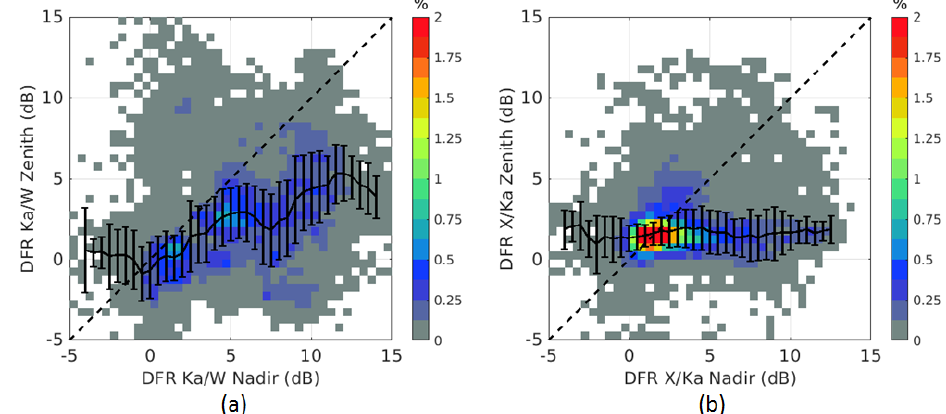
Figure 5. Scatterplots of (a) DFR Ka/W and (b) DFR X/Ka at 245m above and below the aircraft from the 22 November flight. The data grid is 0.5dB. The dashed black line is the 1 : 1 line. The solid black lines are the mean curve and the 1 standard deviation error